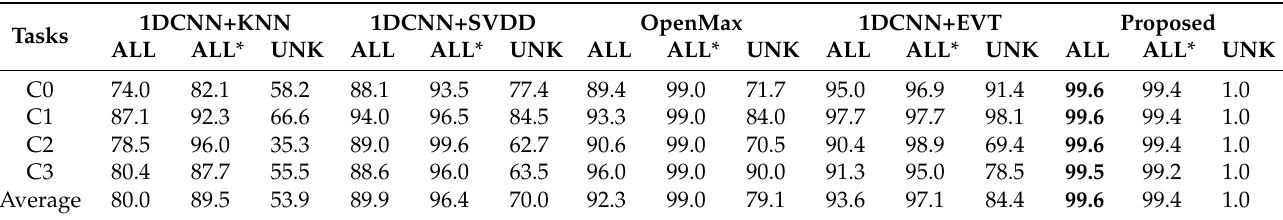
Table 10. Novelty detection performance of CRWU.